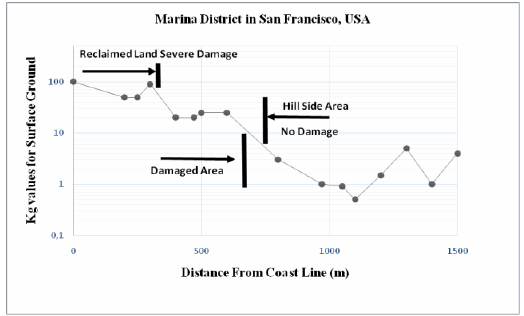
Figure 3. K g -values derived from microtremor recordings in San Fransisco Bay Area (Nakamura, 1997).